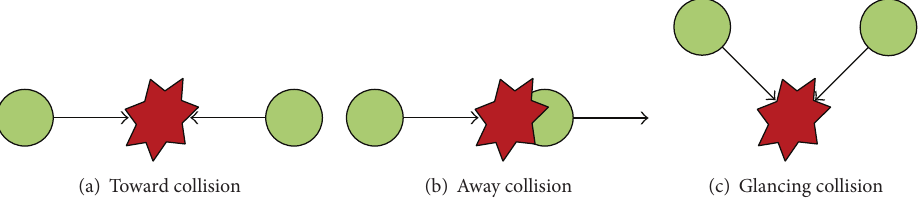
Figure 5: Three types of the collision behaviors.